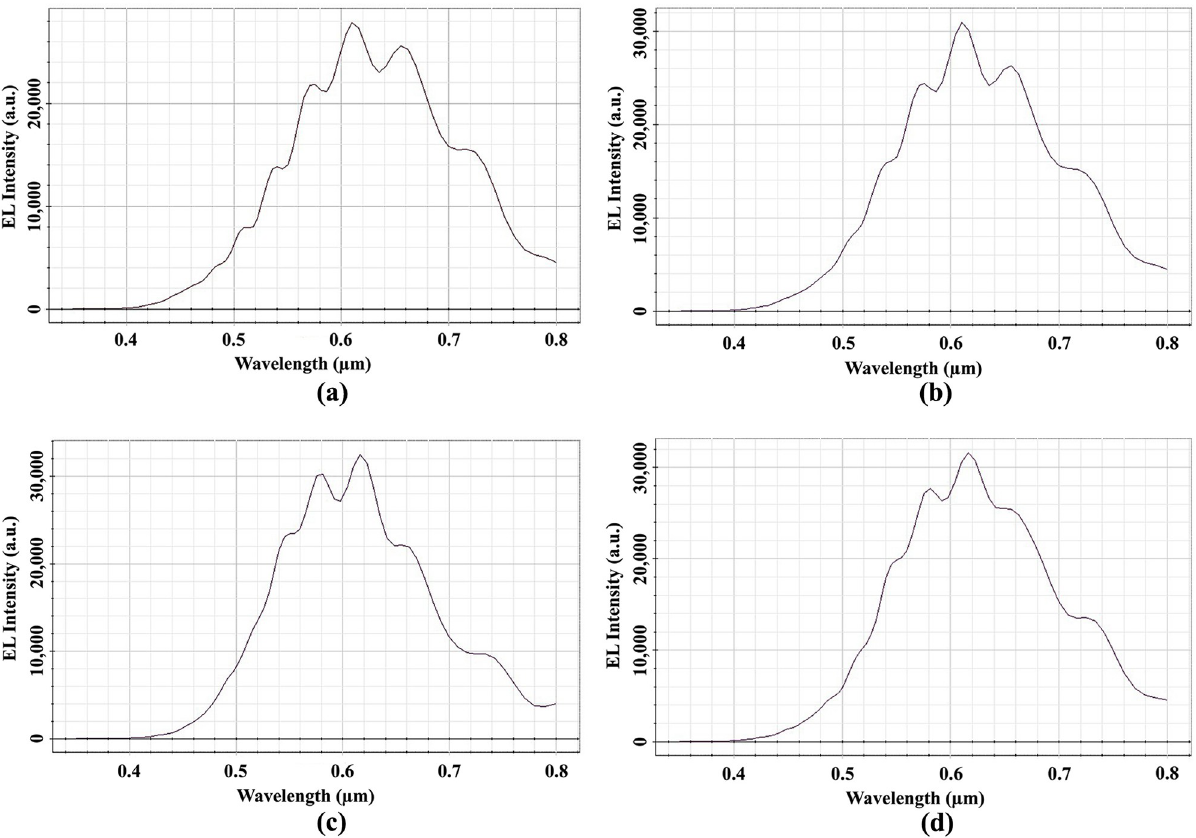
Fig 11. EL Intensity of Ey for spherical planoconcave MLA engraved OLEDs: (a) Spherical-5; (b) Spherical-6; (c) Spherical-7; (d) Spherical 8.